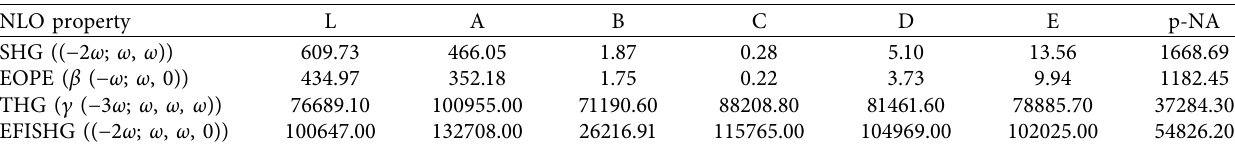
Table 13: Average values of frequency-dependent first and second hyperpolarizabilities (in a.u.) corresponding to some NLO properties of ligand and its transition metal complexes, calculated at frequency ω � 0.04282 a.u. at the wB97XD/6-311++G level of theory. NLO